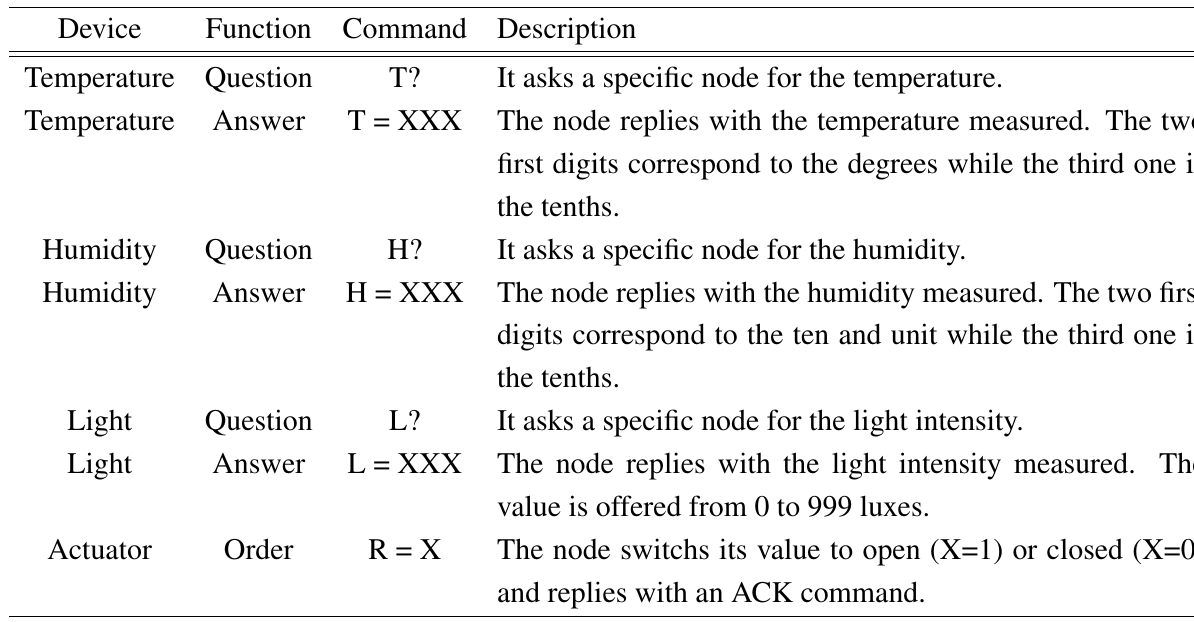
Table 1. Communication protocol: Data types